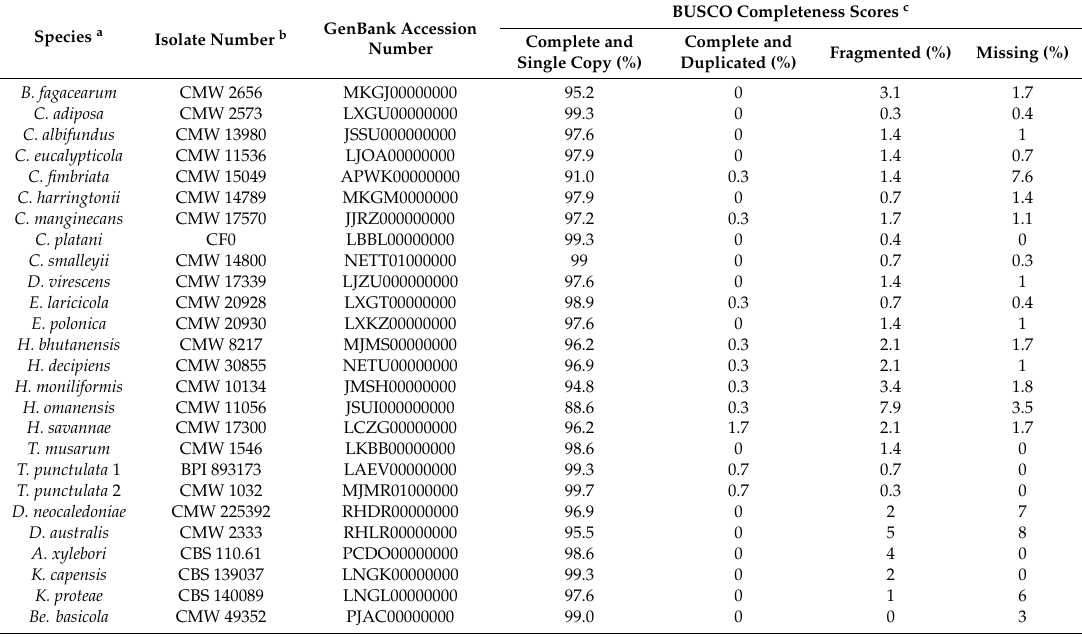
Table 1. Isolate numbers, GenBank accession numbers, and completeness information for the Ceratocystidaceae assemblies included in this